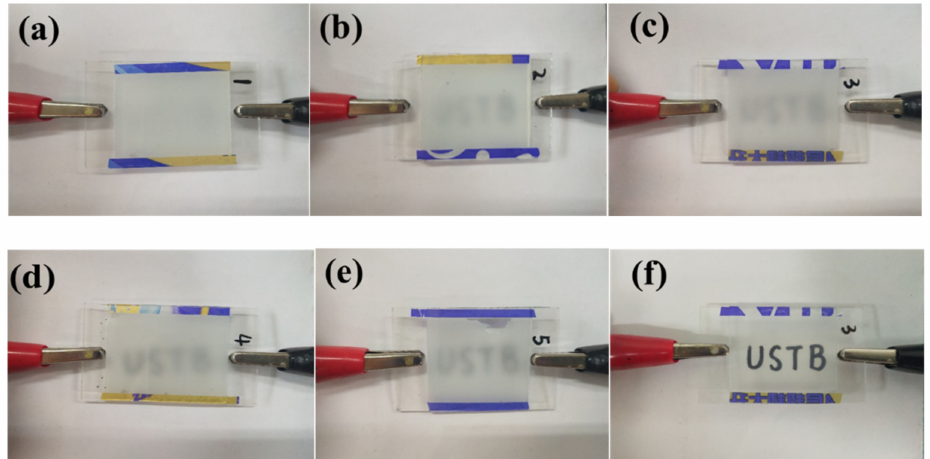
Figure 10. Photographs of samples c1~c5 in the off-state: ( a ) sample c1; ( b ) sample c2; ( c ) sample c3; ( d ) sample c4; ( e ) sample c5; ( f ) sample c3 in on-state